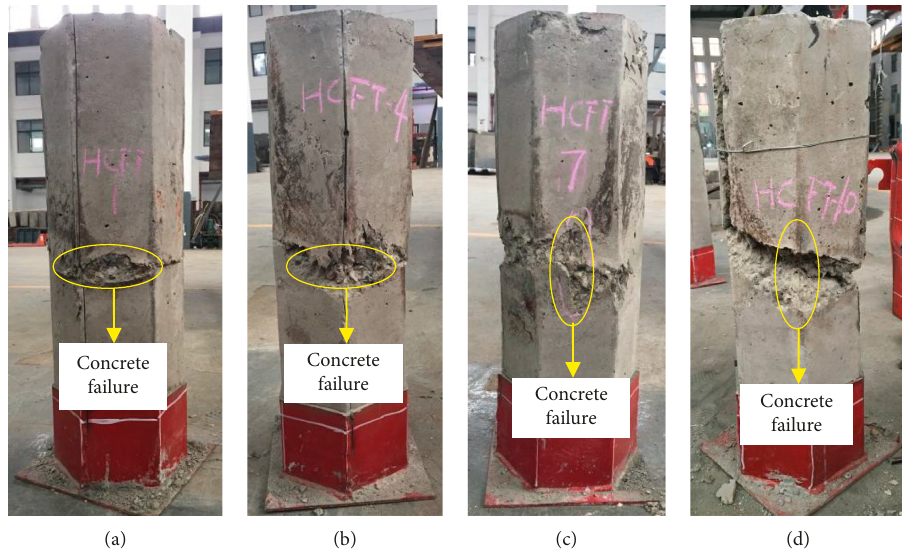
Figure 5: Core-concrete damage of typical specimens. (a) Horizontal slotting in the sideway. (b) Horizontal slotting in the corner. (c) Vertical slotting in the sideway. (d) Vertical slotting in the corner.